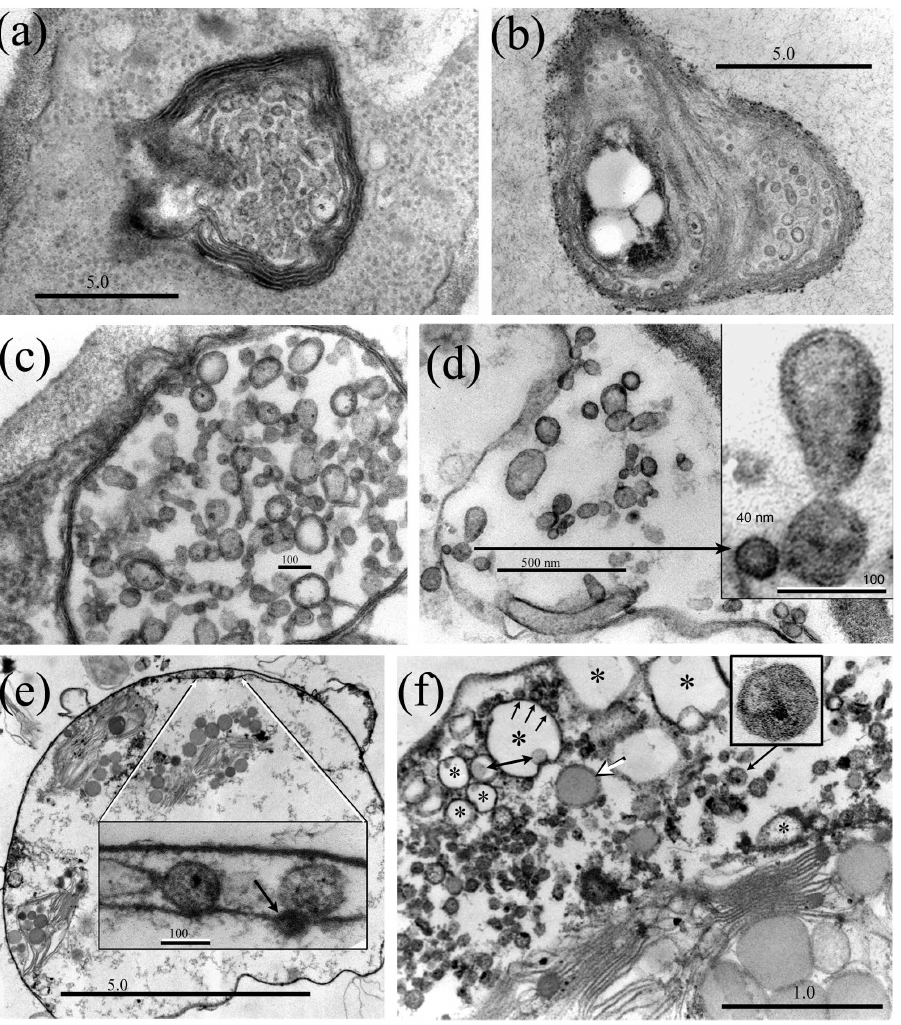
Figure 3. A.pullulans multivesicular bodies release budding Ms-vesicles. (a) Ms-vesicles are formed within multivesicular bodies (MVB). (b) Similar vesicles are present within the periplasmic space of a dividing yeast cell (tangential section). (c) Mature MVB contain large numbers of budding vesicles, which are apparently released into the periplasmic space (d). (d) Inset: An enlarged budding vesicle. (e) Similar budding vesicles are observed within the envelope of modified Psilotum chloroplasts that may be enclosed by a fused fungal plasmalemma (note double-thickness of the outer membrane in the enlarged inset (e), and the ‘eruptions’ from the outer membrane). An opaque vesicle associated with the plastid inner membrane (inset e, arrow) may be budding into the plastid stroma. (f) An infected plastid containing large numbers of dividing vesicles within the expanded envelope. Most of the plastid inner membrane is missing: a short segment (visible right) is lined with vesicles, two with electron lucent centers (asterisk). The vesicles enlarge as electron dense bodies (white arrow), or as vacuole-like forms (asterisks). Note budding from the ‘vacuole’ margin (3 arrows) and presence of internal electron-dense bodies (double-ended arrow). The enlarged vesicle (3f) box) was cultured from modified Cuscuta subinclusa plastids. Bars =(a, b) 5.0 m m; (c) 100 nm; (d) 0.5 m m, inset 100 nm; (e) 5.0 m m, inset 100 nm; (f) 1.0 m m; boxed vesicle is 175